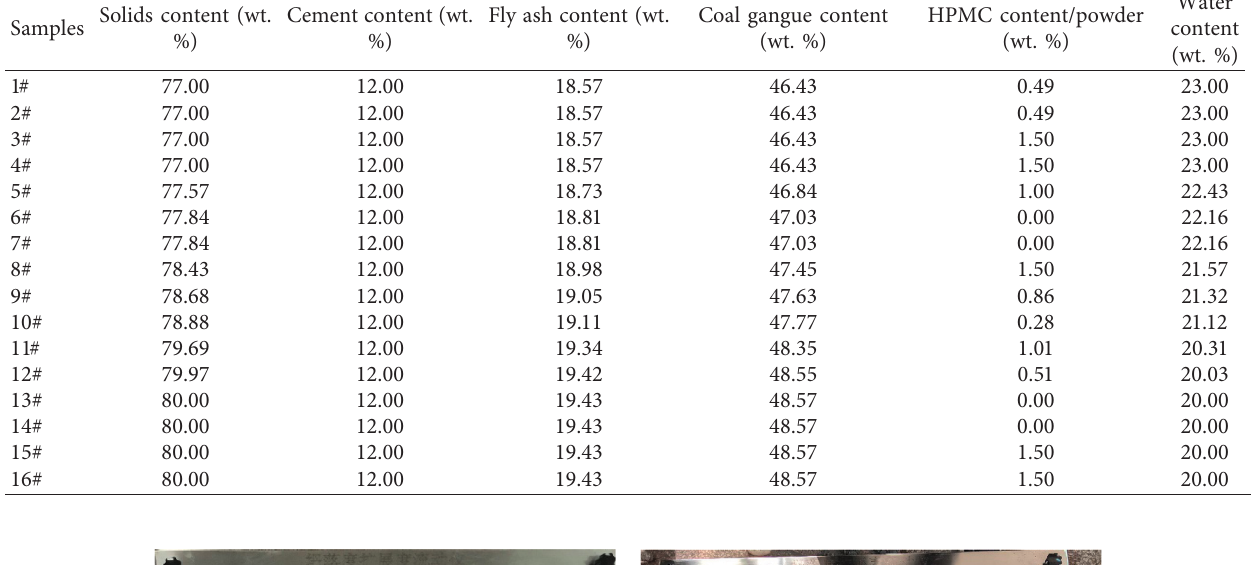
Table 3: Experimental design scheme.